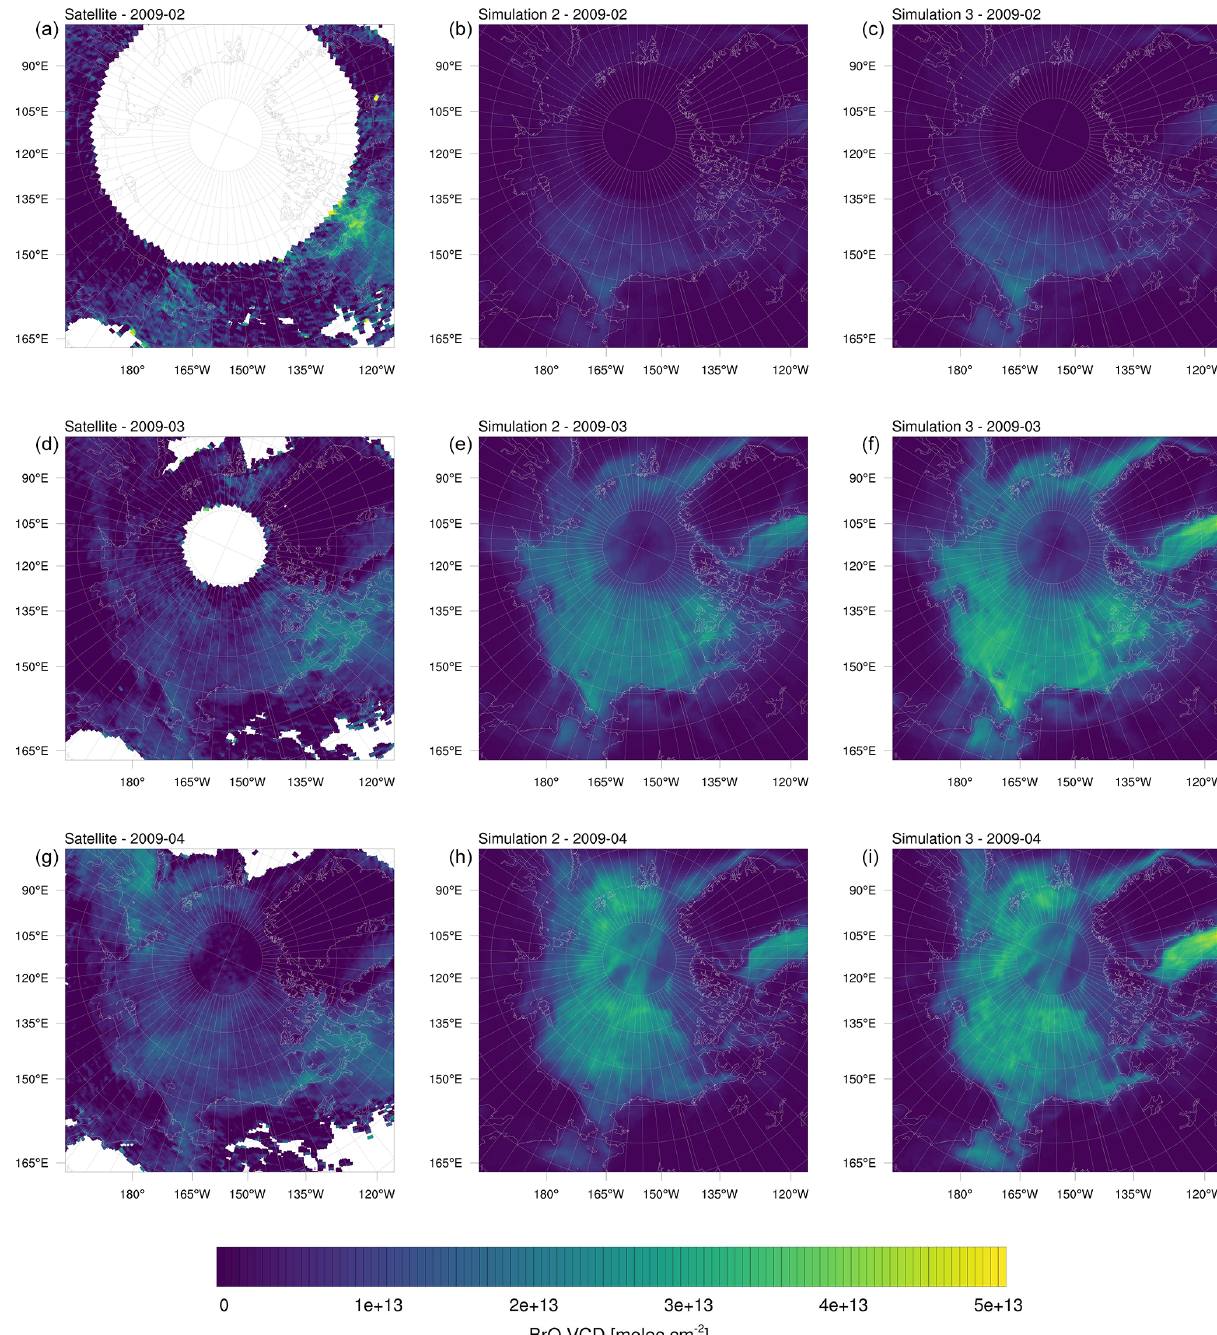
Figure 14. BrO VCDs in the year 2009 averaged over 1 month. (a, d, g) Satellite measurements. (b, e, h) Simulation 2 ( β = 1 . 0). (c, f, i) Simulation 3 ( β = 1 .